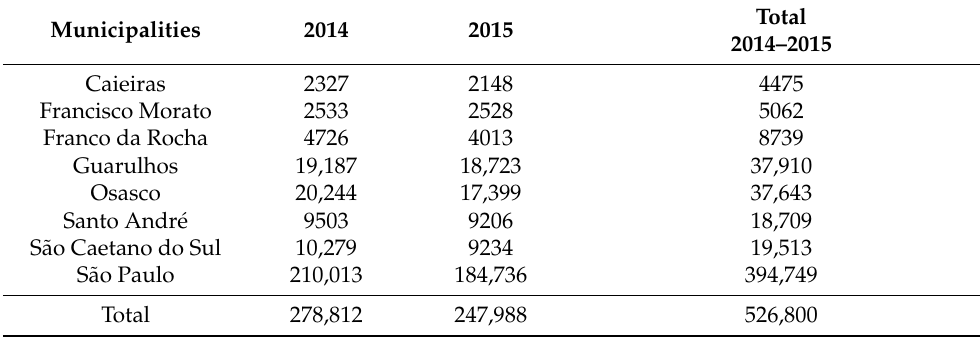
Table 5. Water sector NVA loss by municipalities served by CWSS (BRL 1000).